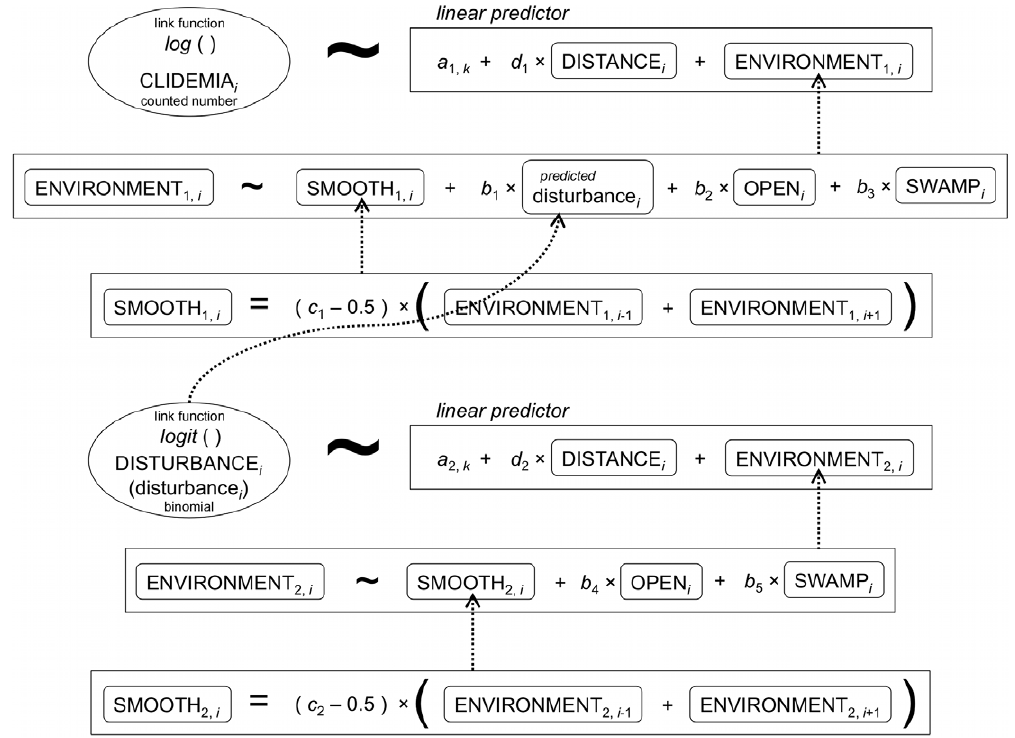
Figure 3. Distribution of measured parameters along each transect. The x-axis represents the distance from the forest edge. The solid line in the middle of each panel represents the abundance of Clidemia hirta . The bar in the middle of each panel represents intensity of soil disturbance (scale 0–5). Bars at the top and bottom of each panel represent the location of canopy openings and swampy areas, respectively.